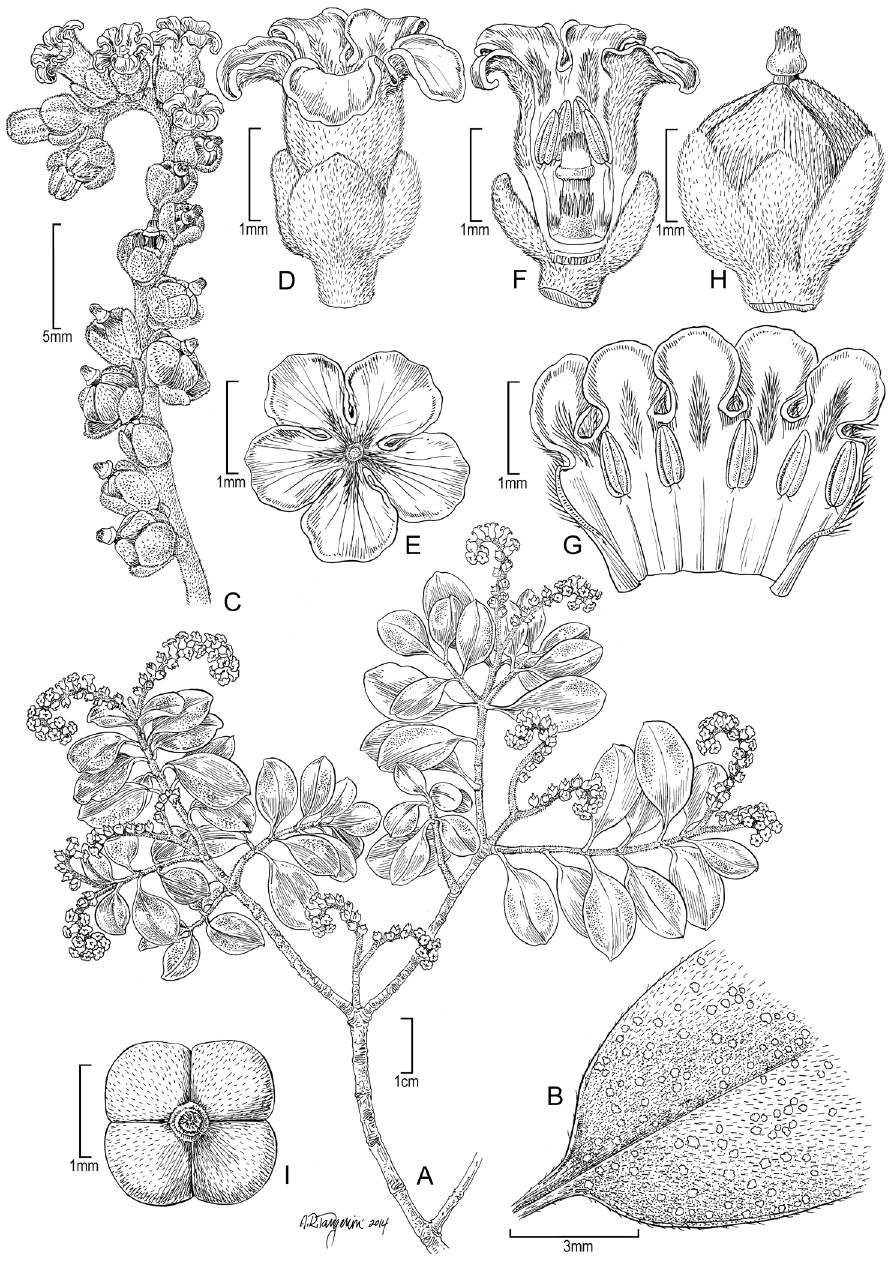
Figure 1. Heliotropium perlmanii Lorence & WL Wagner A Habit B Upper leaf surface, C Inflorecence D Flower, lateral view E Corolla, face view F Flower, longitudinal section showing stamens and gynoe- cium G Corolla, sectioned to show stamens and indument, H Fruit and calyx, lateral view I Fruit showing 4 carpels. All figures drawn from Perlman & Florence 10052 (US) and photos from Falaise Est Eiao, 11 March 2007 courtesy of J-F